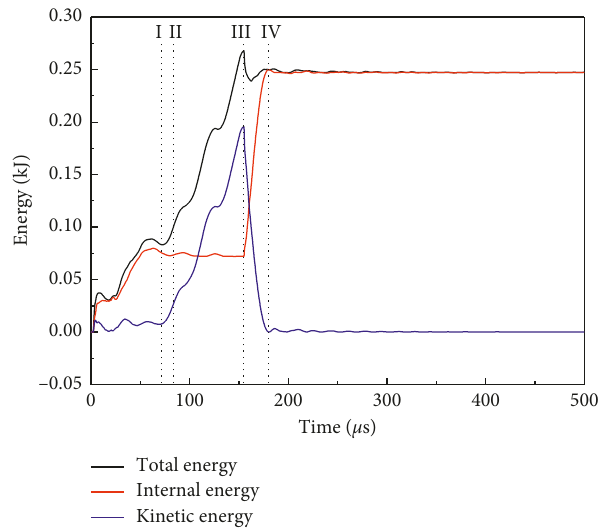
Figure 23: Energy histories of the piston at 442 ° mg charge amount.